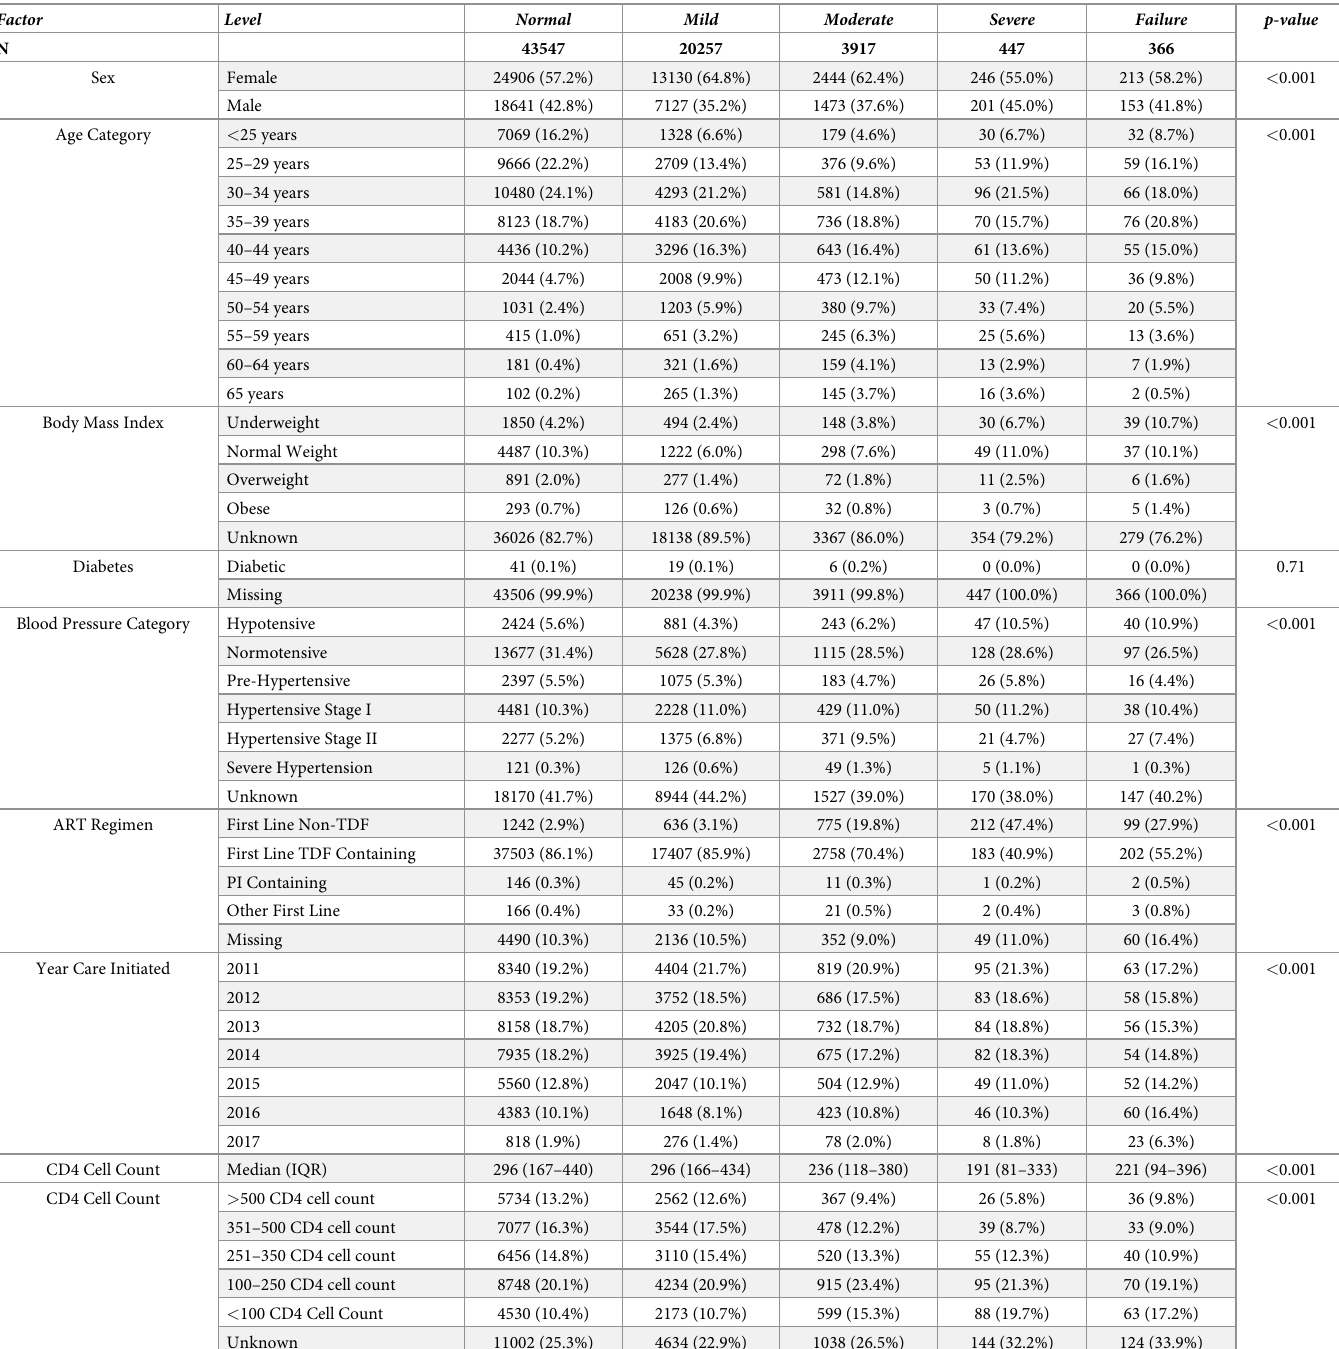
Table 1. Analysis population characteristics by CKD-EPI estimated glomerular filtration rate category at ART initiation